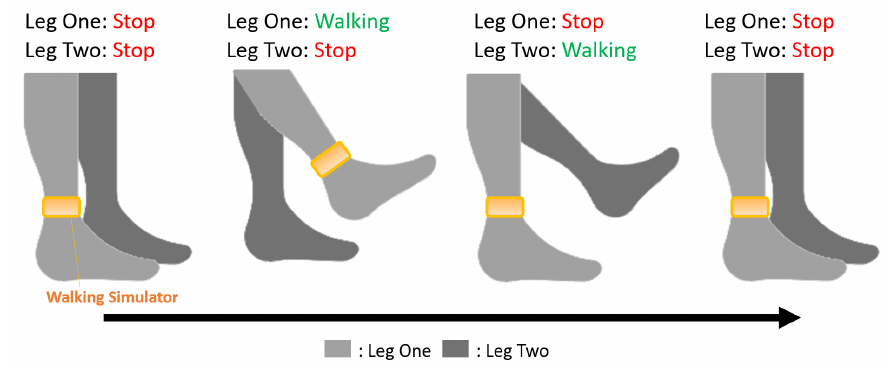
Figure 2. Schematic of single-leg walking decision algorithm. Images from the left to the right in the figure depict walking steps 1–4. Step 1 corresponds to the initialize state, and steps 2–4 show the state of leg 1 is decided by the walking simulator, the state of leg 2 is determined based on the previous state of leg